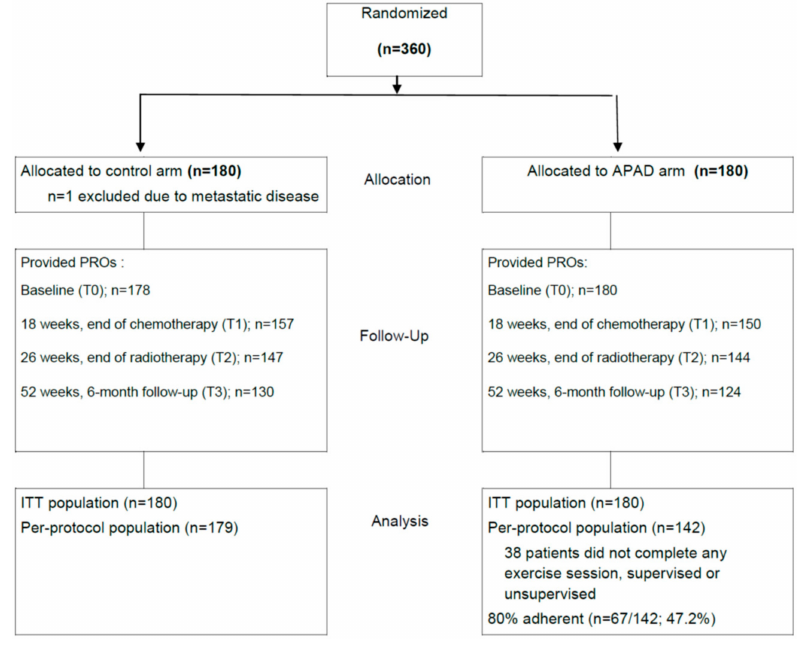
Figure 2. CONSORT diagram of the